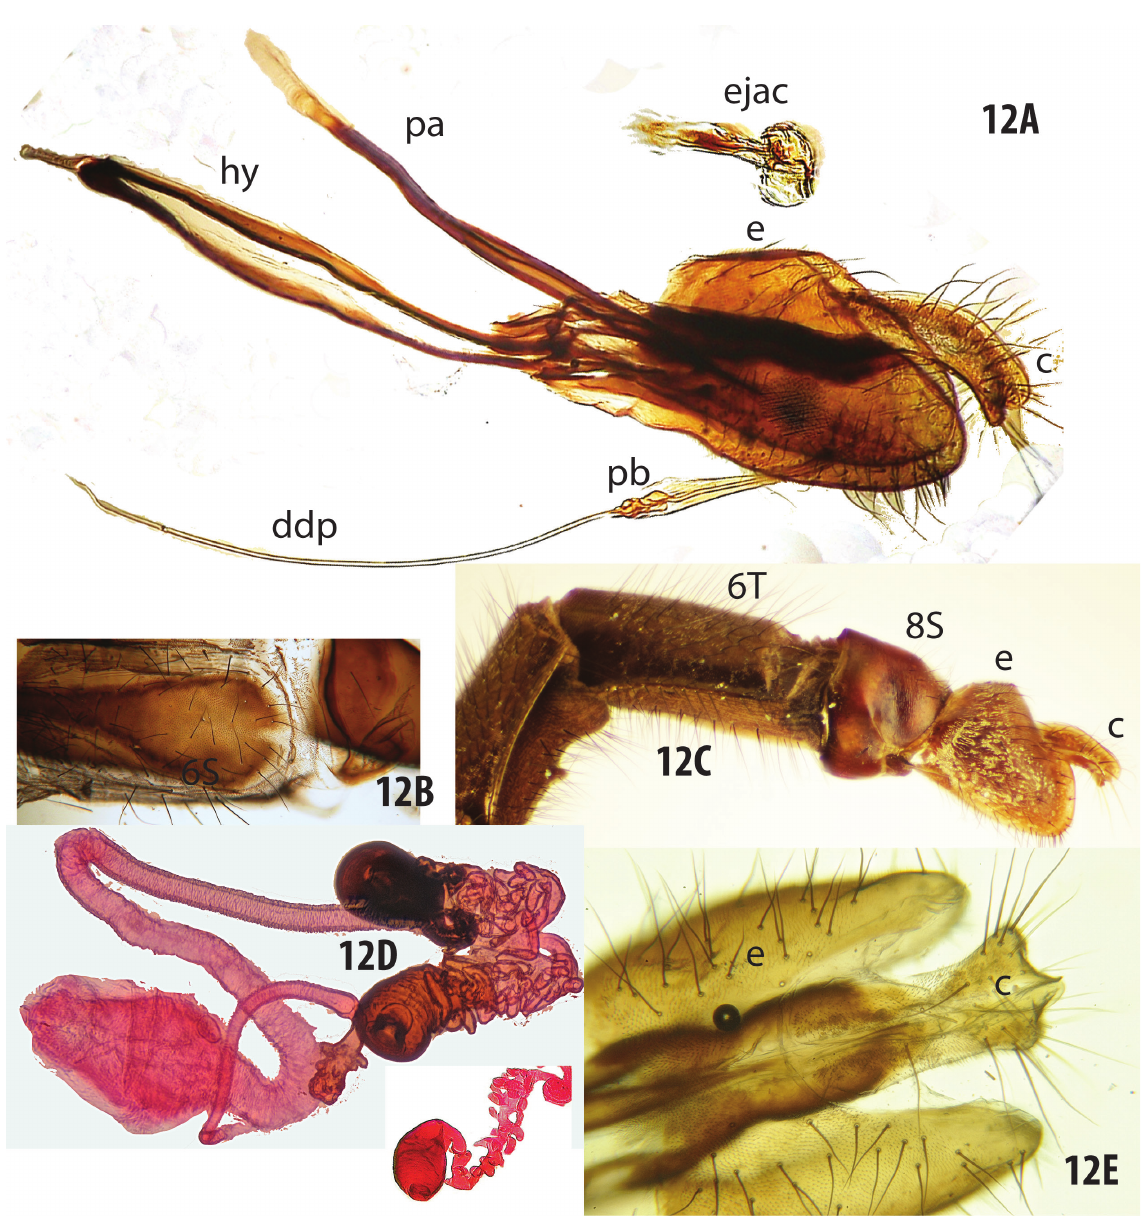
Fig. 12. Mesoconius nigripleuron sp. nov., internal characters, Peru. A . Male terminalia, lateral view. B . S6 to S8, ♂. C . Abdomen, ♂. D . Spermathecae and associated structures (inset: one of the paired spermathecae with a partially uncoiled stem). E . Male epandrium and cerci, posterodorsal view. Abbreviations: c = cercus; ddp = distal distiphallus; e = epandrium; ejac = ejaculatory apodeme; hy = hypandrium; pa = phallapodeme; pb = phallic